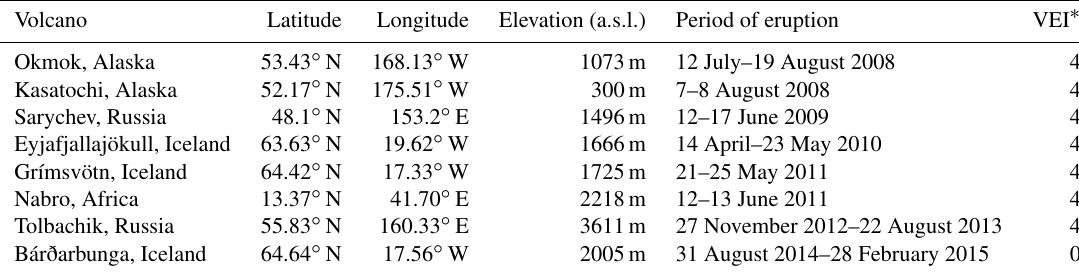
Table 1. Volcanic eruptions in the past decade considered in this study. Volcano Latitude Longitude Elevation (a.s.l.) Period of eruption VEI ∗ Okmok, Alaska 53.43 ◦ N 168.13 ◦ W 1073m Kasatochi, Alaska Sarychev, Russia Eyjafjallajökull, Iceland Grímsvötn, Iceland Nabro, Africa Tolbachik, Russia Bárðarbunga,